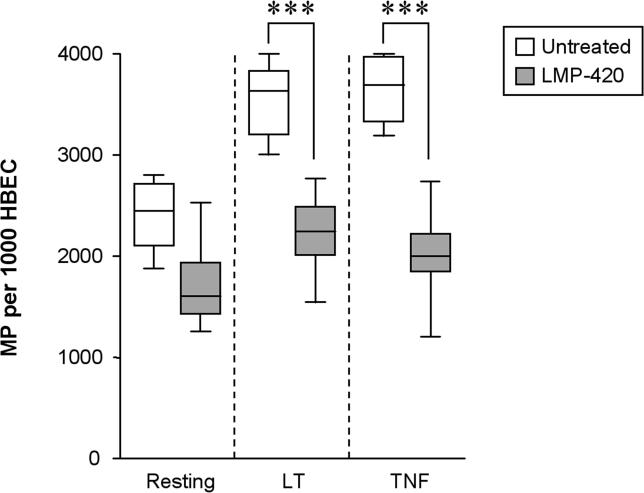
Inhibitory Effect of LMP-420 on LT- and TNF-Induced Increase of MP ReleaseHBEC-5i were cultured and left resting or stimulated with TNF, TNF with LMP-420, LT, or LT with LMP-420 for 6 h before analysis. MP production was quantified by flow cytometry for each condition. Results (four determinations in four experiments) are expressed in numbers of MP labeled with annexin V-FITC, extracted from culture supernatants of 103 HBEC-5i (Dunn's test, *** corresponds to p < 0.001).